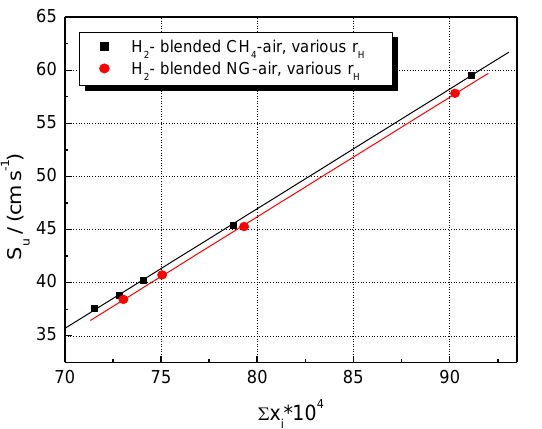
Figure 11. Experimental LBV of stoichiometric CH 4 – H 2 – air and NG – H 2 – air mixtures in correlation with the peak values of volumetric rates of heat release; flames at ambient p 0 and T 0 .